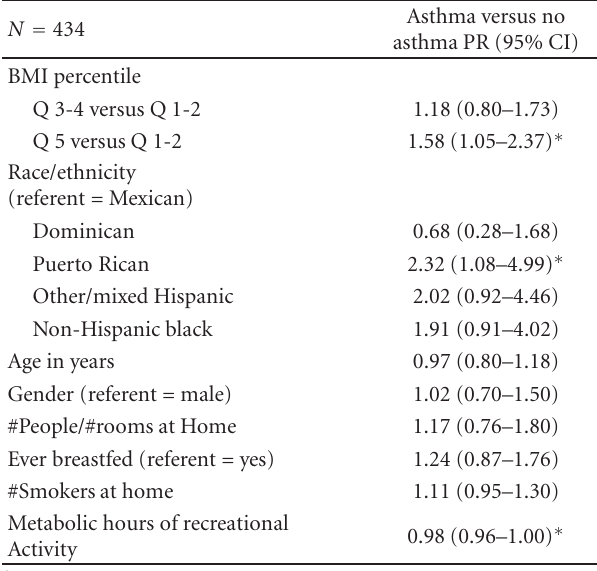
Table 6: Explanatory asthma